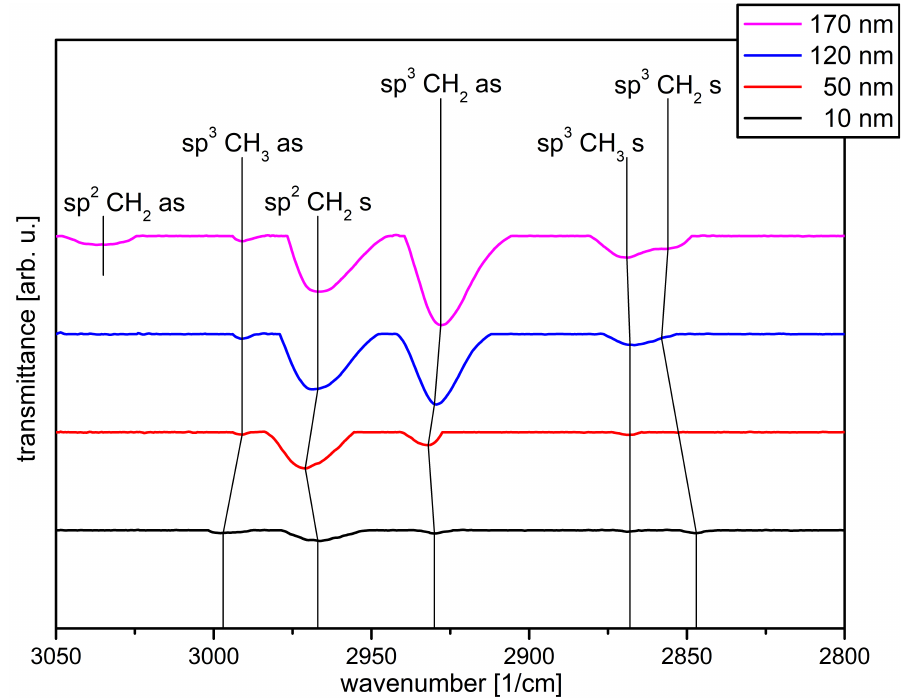
Figure 6. Evaluated DRIFT spectra of the “fixed” PHB samples coated with a-C:H from 10–170 nm in ascending order. The wavenumber is plotted against the transmittance in arbitrary